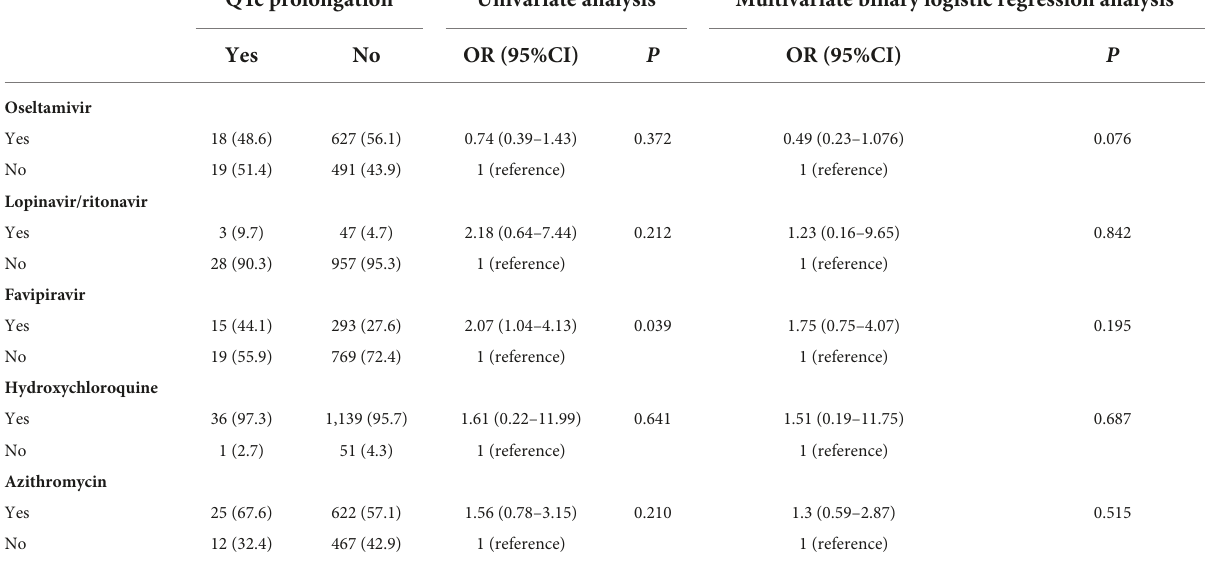
TABLE 5 QTc prolongation during treatment with drugs. QTc prolongation Univariate analysis Multivariate binary logistic regression